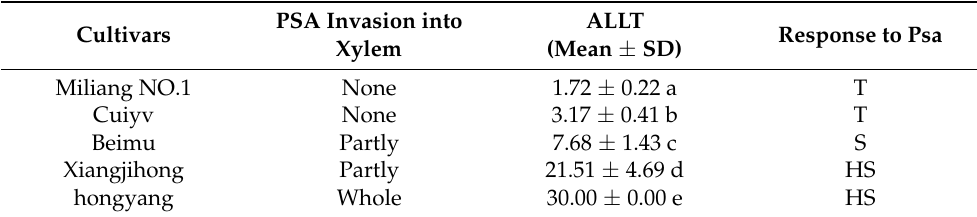
Table 1. Response of five kiwifruit cultivars to in vitro inoculation with Pseudomonas syringae pv. actinidiae (Psa).